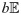

bE power laws.The figure is based on eight healthy subjects. The plot shows how the complexity of different SMS behave with the increasing stress index, pGSI. The curves show that complexity of all SMS increases except for the complexity of the SpO2.